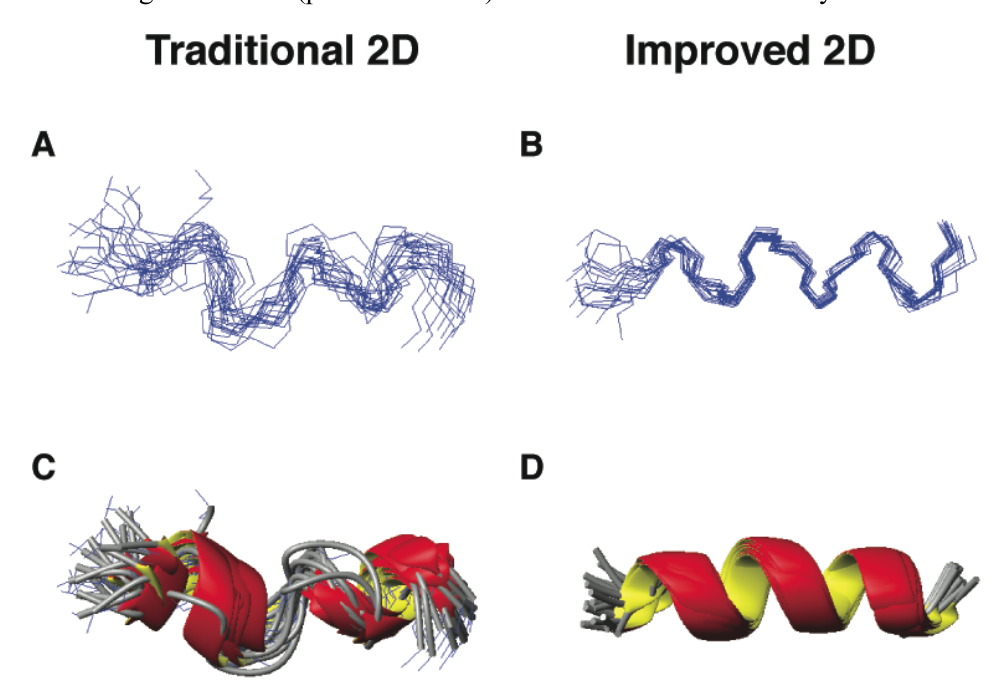
Figure 5. Three-dimensional structures of DFTamP1 determined by traditional (panels A and C) [103] and improved 2D NMR methods (panels B and D) [50]. Shown are ensembles of backbone structures (A and B) and ribbon diagrams (C and D). All the NMR data were recorded on a 600-MHz NMR spectrometer using a 2 mM peptide in complex with 40-fold deuterated sodium dodecyl sulfate at 25 °C and pH 5.4. Structures (panels A and C) were determined as described previously [55] and the structures without the use of chemical shift-derived angle restraints (panels B and D) were calculated in this